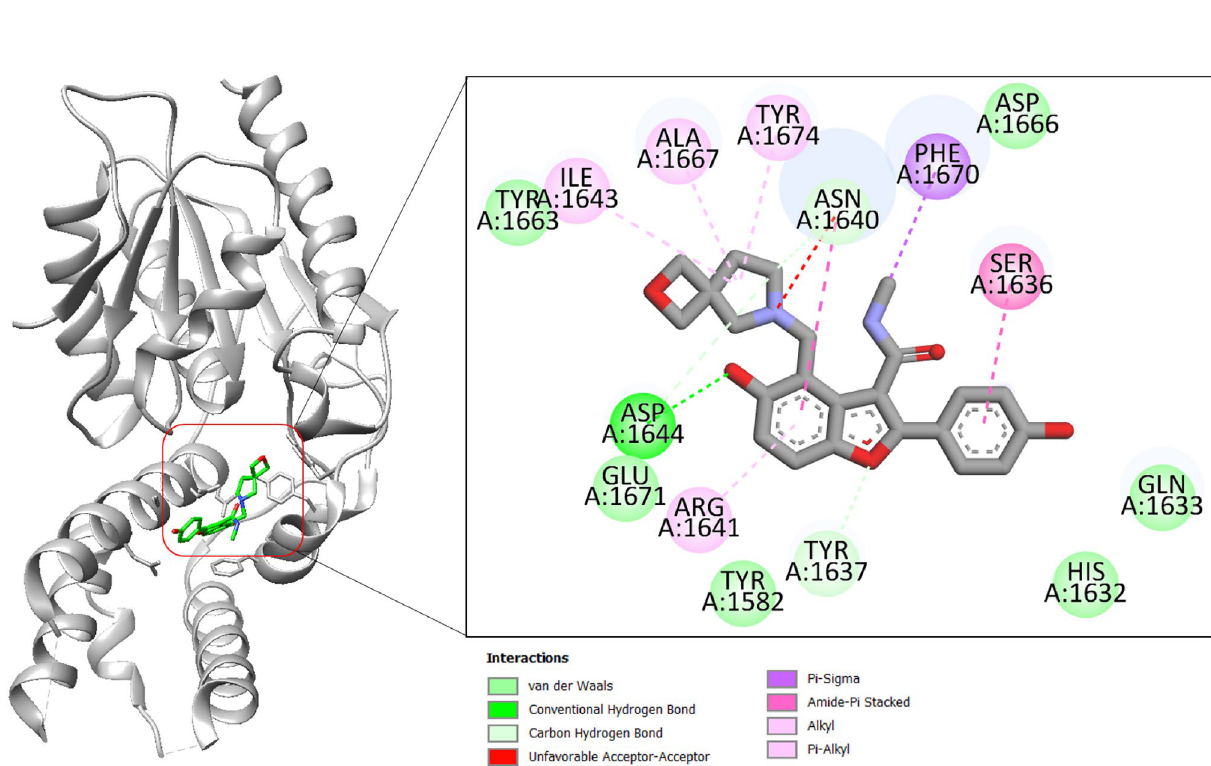
Figure 4. Binding mode of control compound at the active pocket of polyketide synthase Pks13. The receptor enzyme is given in gray cartoon while the compound is presented in green stick. The binding interactions network is also